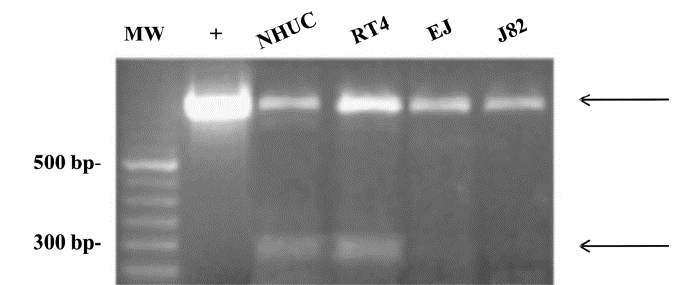
Figure 2. s-TRPV2 expression in human normal urothelial and urothelial carcinoma cell lines. cDNA from NHUCs and RT4, EJ, and J82 cell lines was amplified by PCR for TRPV2 expression. PCR products were analyzed by electrophoresis on 2% ethidium bromide-stained agarose gel. The hTRPV2-plasmid construct was used as positive control (+). Arrows indicate the two products obtained. MW = molecular